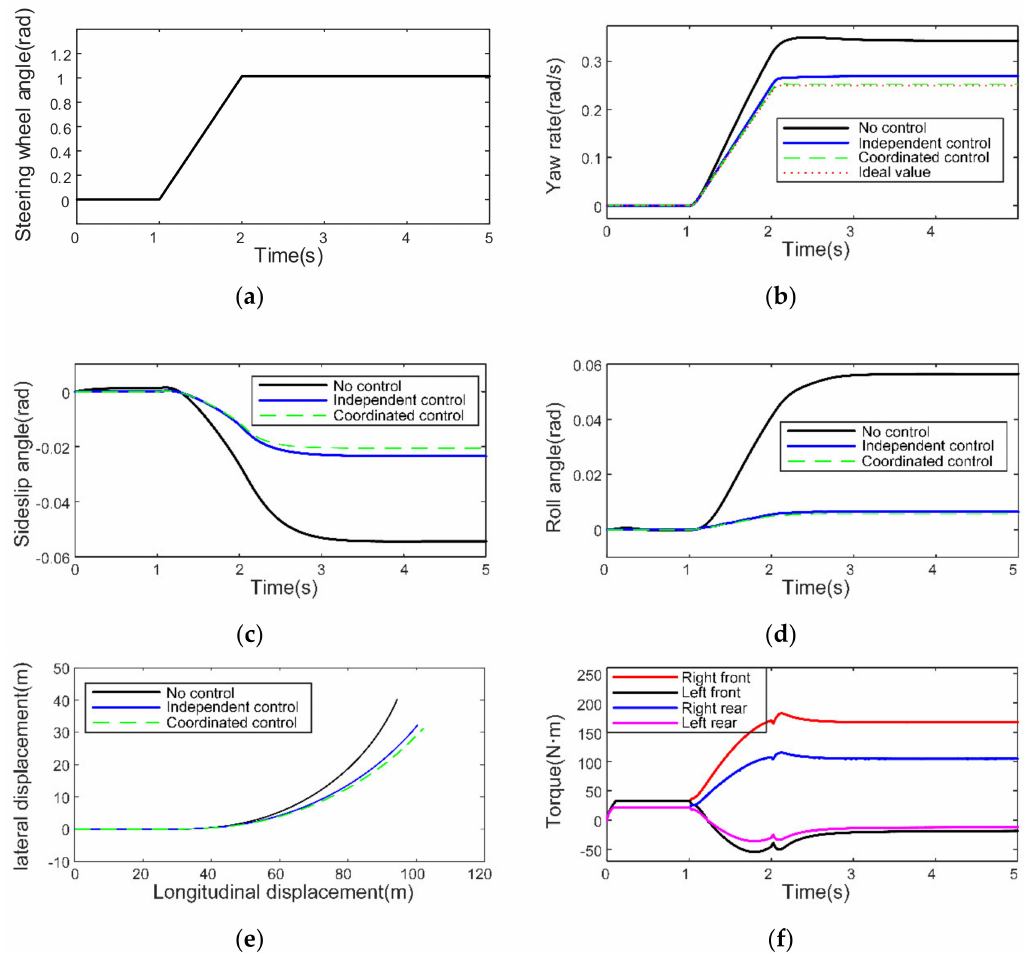
Figure 9. Stability performance under ramp steering. ( a ) steering wheel angle; ( b ) yaw rate; ( c ) sideslip angle; ( d ) row angle; ( e ) vehicle trajectory; and ( f ) wheel